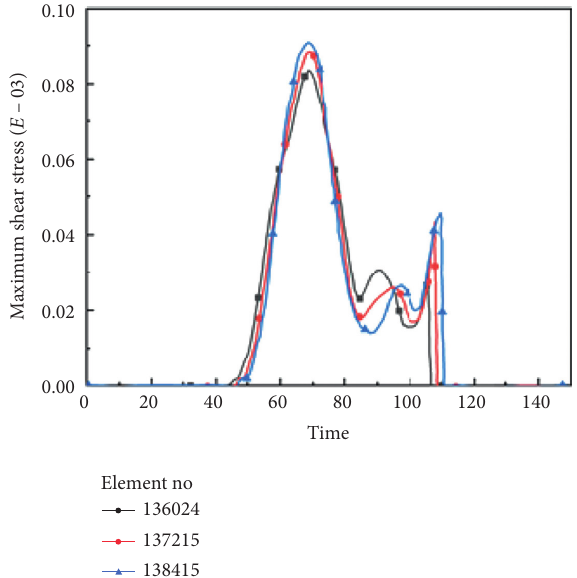
Figure 14: Curve of maximum shear stress-time on selected elements.